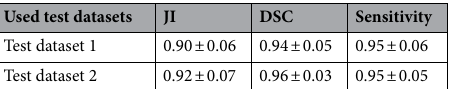
Table 1. Segmentation results. JI Jaccard index, DSC Sørensen–Dice